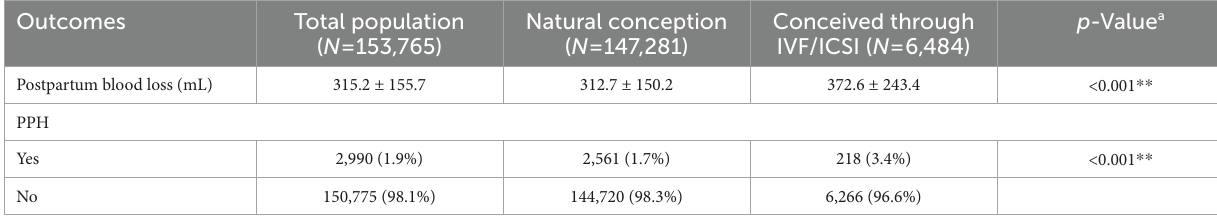
TABLE 2 Distributions of the amount of postpartum blood loss and